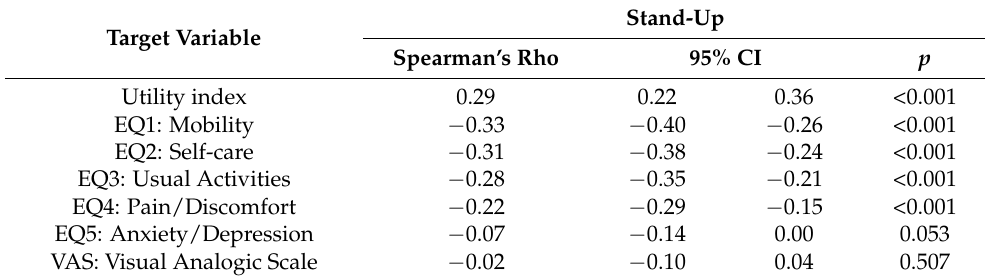
Table 1. Correlation between stand-up test and EQ-5D-3L in older women with depression.